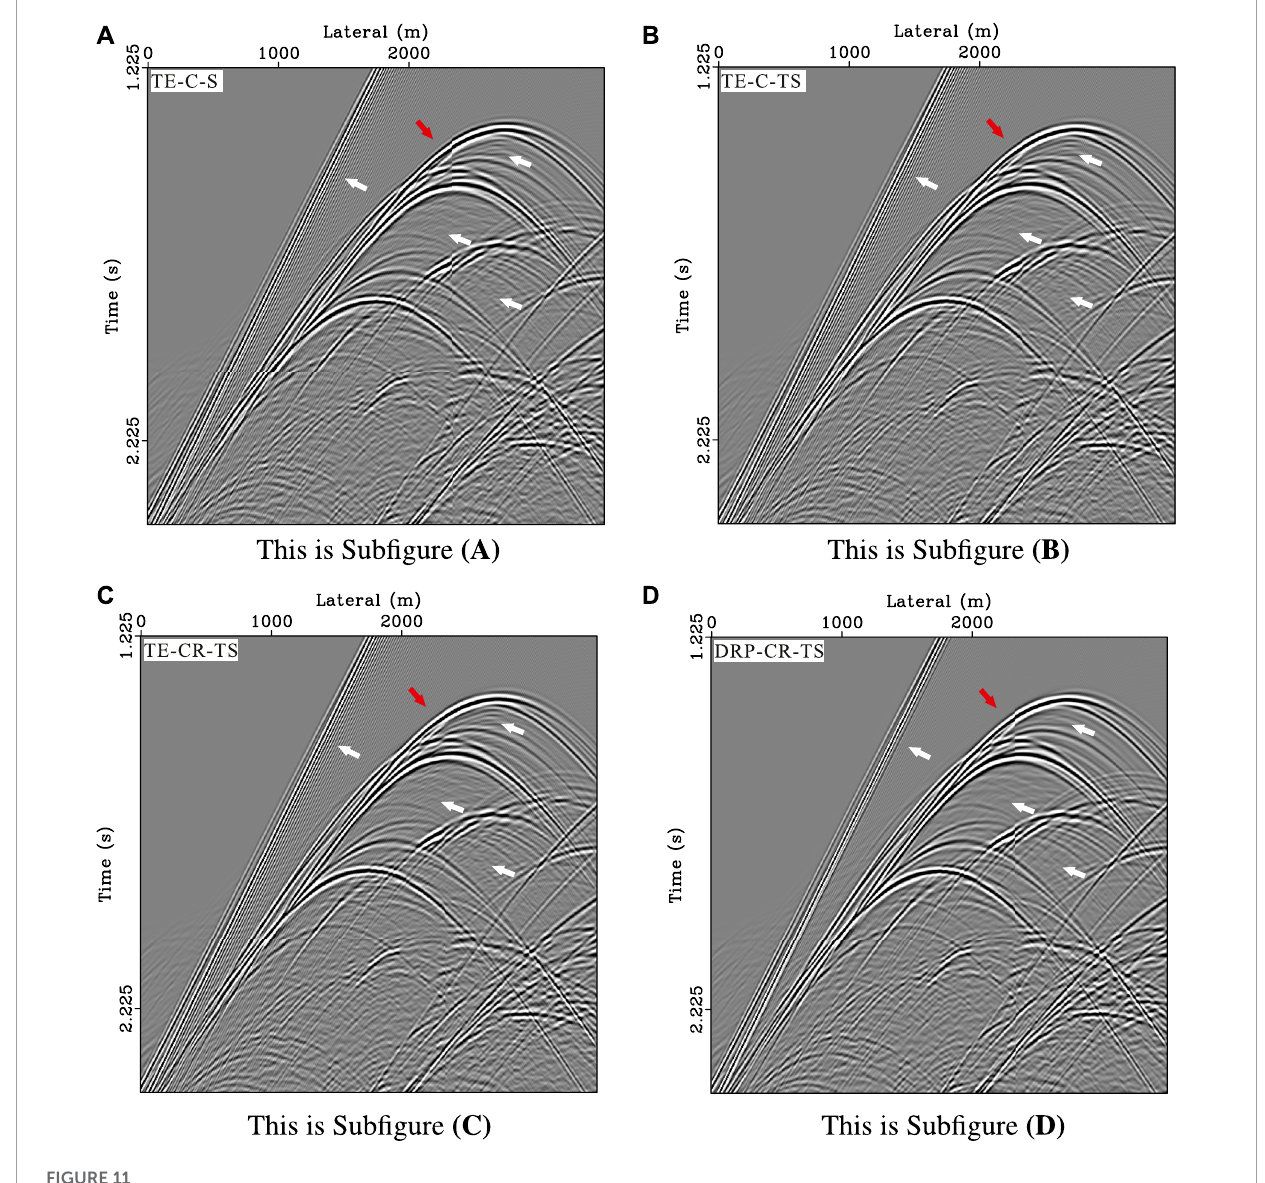
FIGURE 11 Seismic records of the four methods. (A) TE-C-S method. (B) TE-C-TS method. (C) TE-CR-TS method. (D) DRP-CR-TS